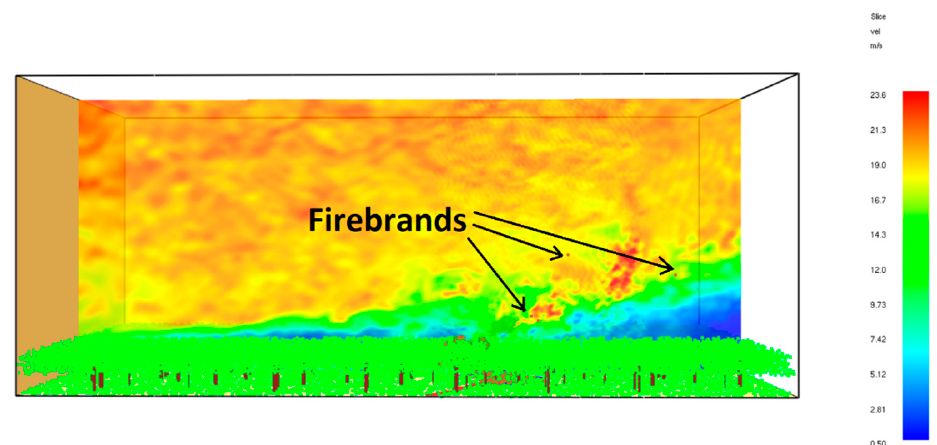
Figure 12. A snapshot of Smokeview of firebrand transporting with the effect of wind and fire